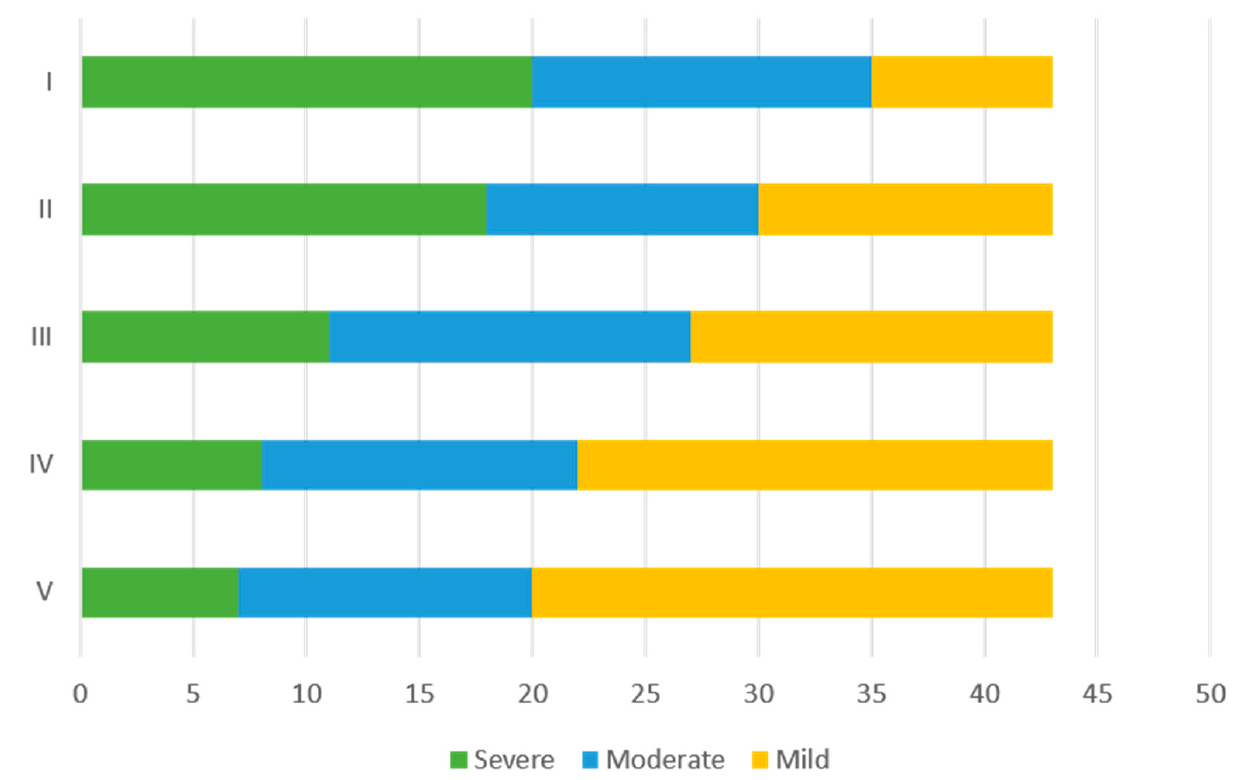
Figure 5. Frequencies of patients reporting an average of mild, moderate, or severe intensity of headache attacks for each cycle of OBT-A.